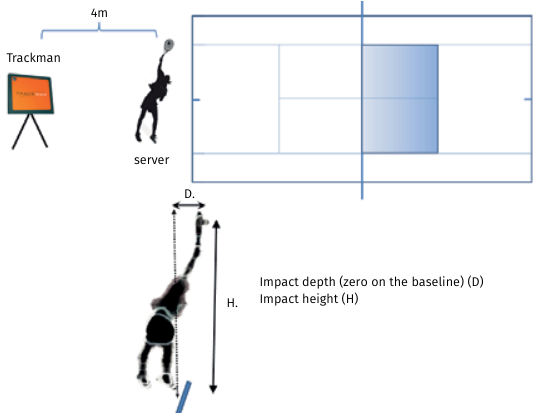
Figure 1. Experimental set up for service performance test and service impact